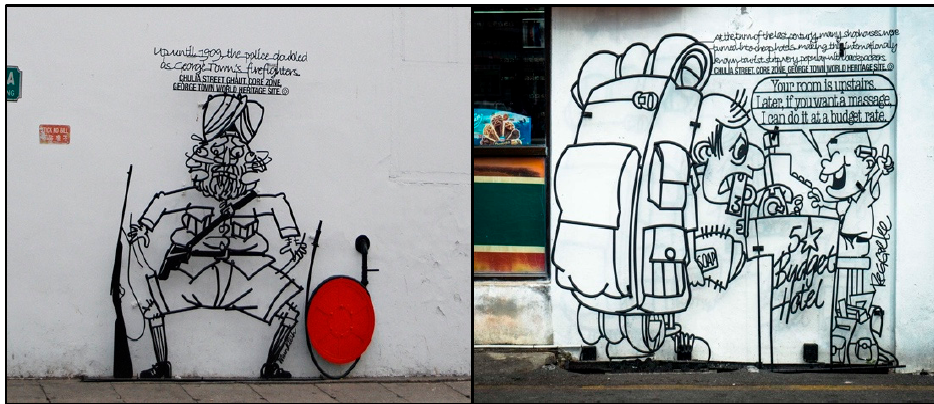
Figure 2. Steel Rod Sculptures in George Town. Source: [21].